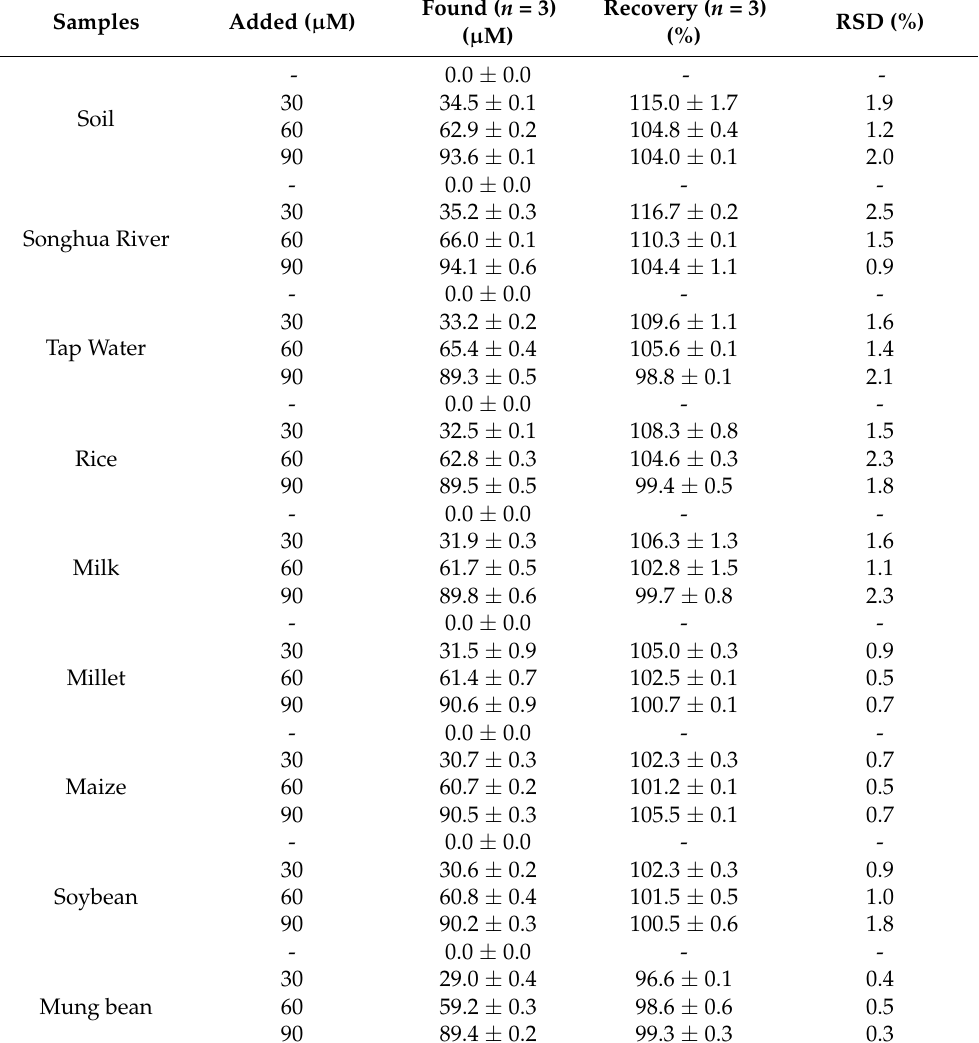
Table 1. Detection of glyphosate in water samples and soil samples using the proposed method.